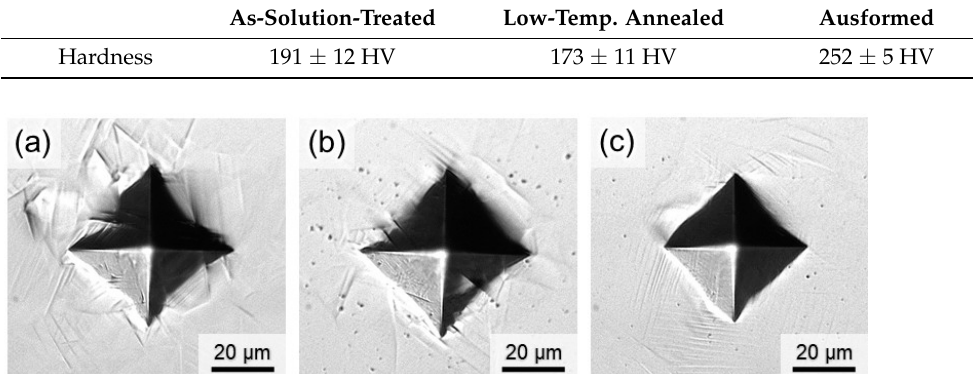
Figure 8. Indents after the Vickers hardness tests in ( a ) as-solution-treated, ( b ) low-temperature- annealed, and ( c ) ausformed specimens.